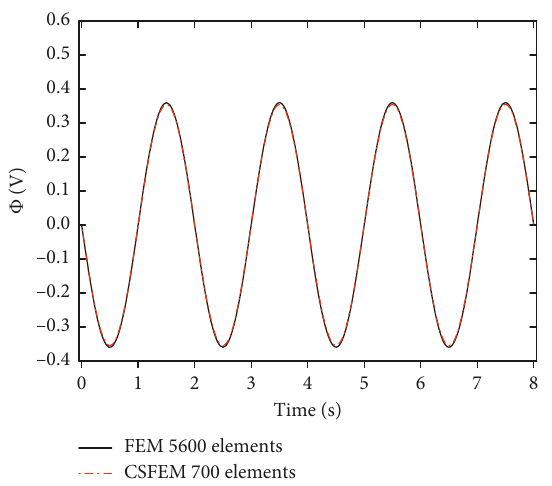
Figure 27: The variation of the electrical potential V of the PCMs energy harvester at point A with respect to time.